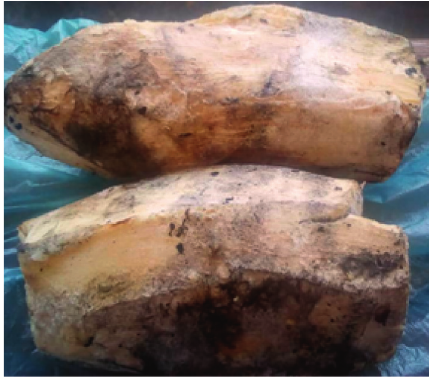
Figure 1: Braised